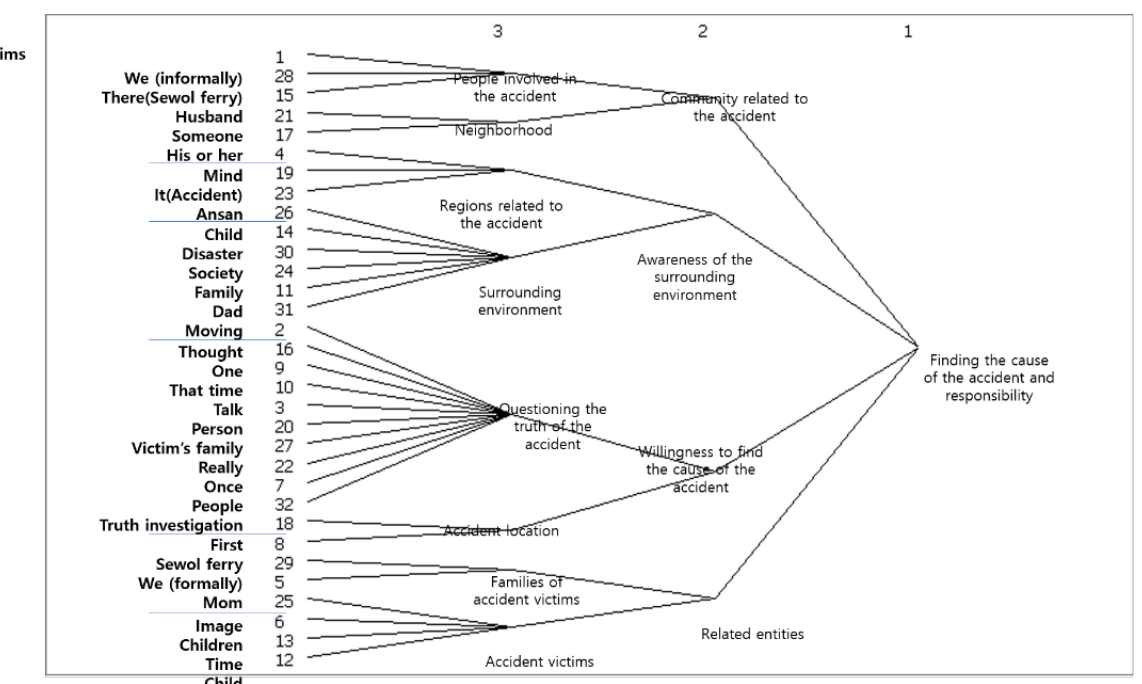
Figure 2. Similar word clusters and the meanings of victims’